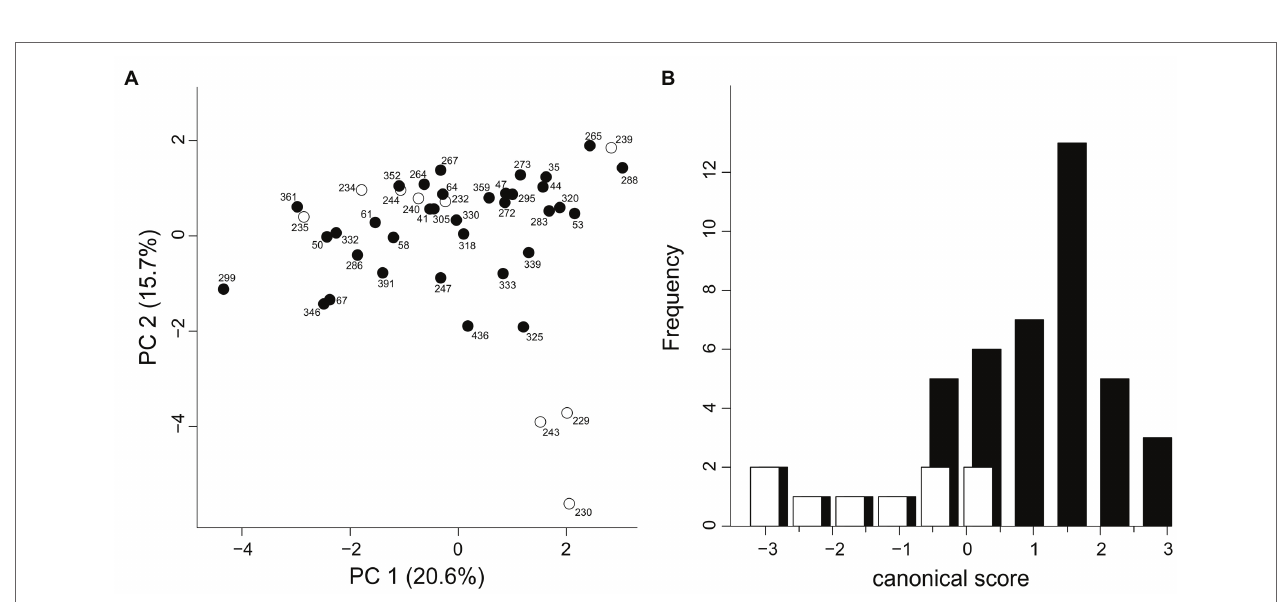
FIGURE 6 | Morphological variation in H. niger based on 15 morphological characters describing the shape of rosette leaves; one individual each from 44 populations was investigated. White, Western Group; black, Eastern Group. (A) Principal component analysis. (B) Canonical discriminant analysis.